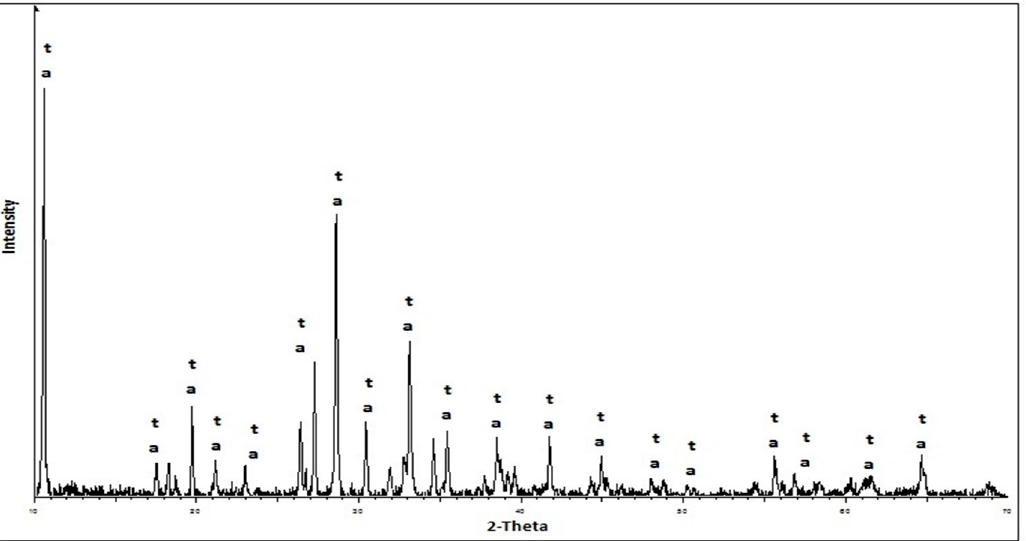
Figure 2. X-ray phase analysis of a low grade nephrite.